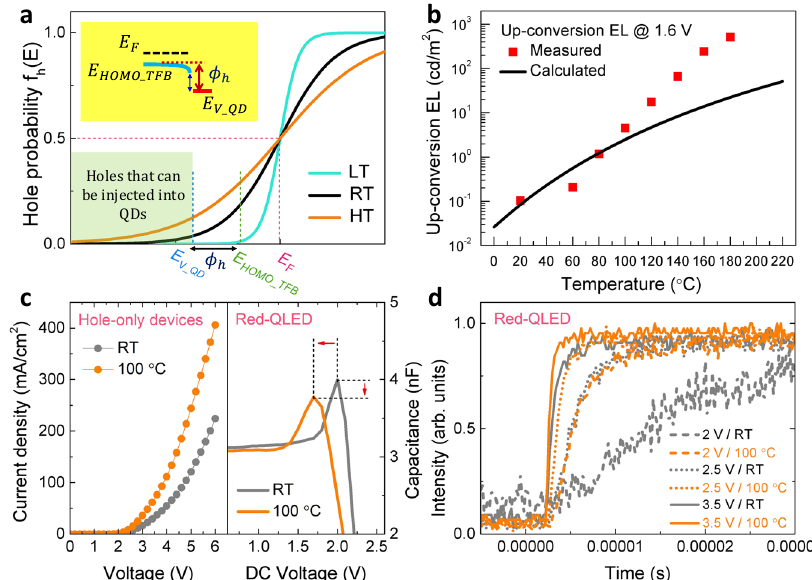
Fig. 3 Thermal-assisted hole-injection. a The probability of fi nding the holes at different energy: when the temperature is elevated, the probability that the holes can be injected into QDs is remarkably increased. b Up-conversion EL at 1.6 V under different temperatures: the calculated results agree fairly well with the measured one when the temperature is lower than 80 °C. At high temperature, the discrepancy is caused by the thermal excitation that increases the hole concentration of TFB. c The current density (J)-V characteristics of hole-only devices and capacitance-V characteristics of the red QLEDs at RT and 100 °C: at elevated temperature, the hole current is substantially enhanced, which thus reduces the peak capacitance of the devices. d The transient EL of red-QLEDs: at elevated temperature, the devices are turned-on more rapidly due to enhanced hole